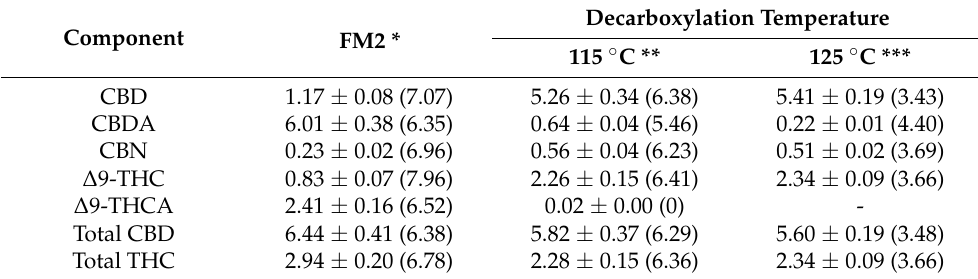
Table 2. Contents of the main cannabinoids in Cannabis FM2 in the starting material and after decarboxylation at different temperatures, namely 115 and 125 ◦ C. Results are expressed as mean (%, w/w) ± standard deviation